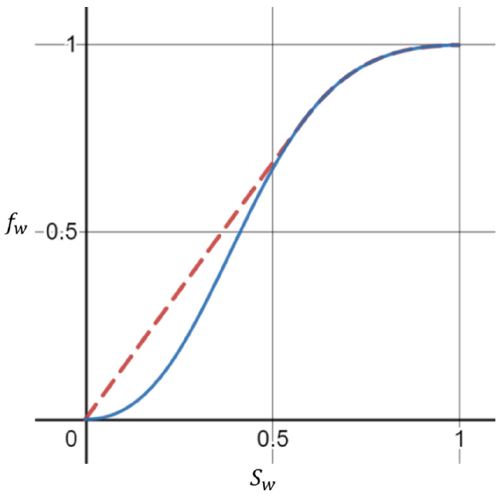
Figure 1. Nonconvex fractional flow function (blue) with an Oleinik entropy condition concave envelope (dashed red).